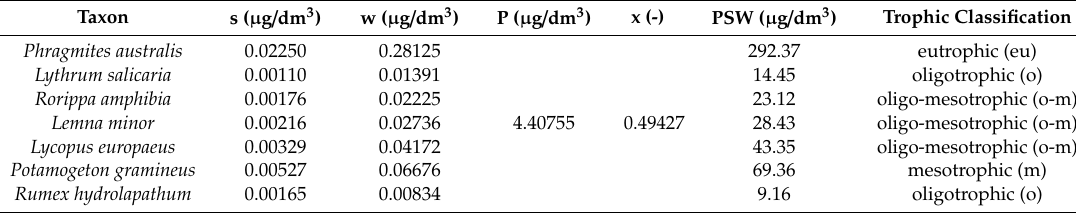
Table 14. Summary of the TIM results, May 2017, section below the SHP on the ´Sl˛eza.